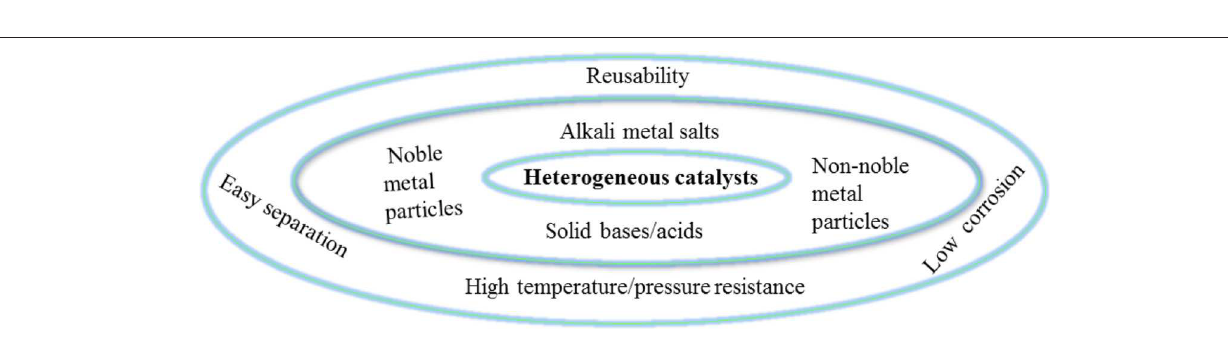
FIGURE 2 | Advantages of heterogeneous